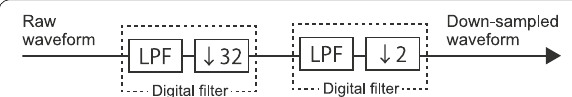
Fig. 9 A block diagram of the cascaded decimation filter